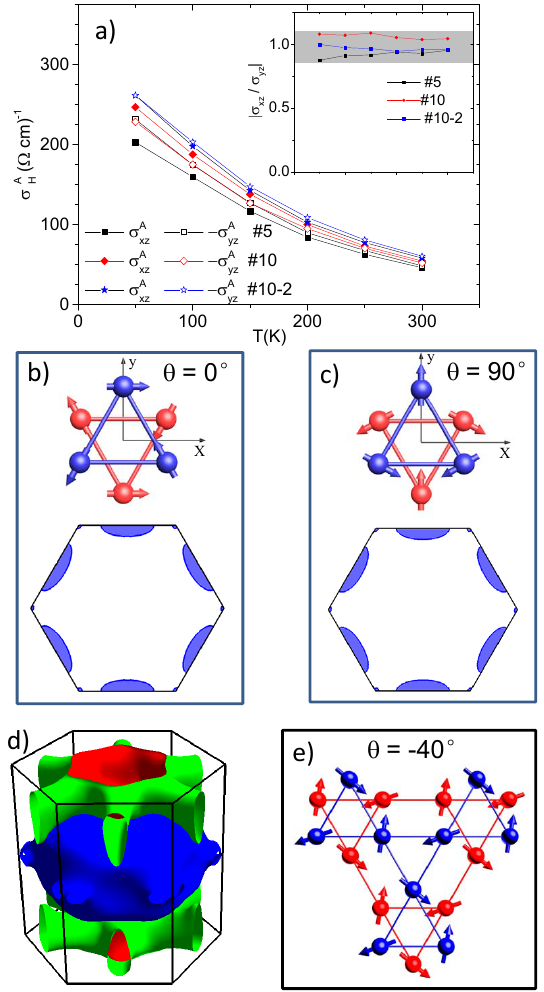
Figure 3: In-plane isotropy: a) Temperature-dependence of the anomalous Hall conductivity for two perpendicular orientations of the magnetic field in three dif- ferent samples. The inset shows the in-plane anisotropy found in these fixed-angle measurements and the experimental margin (in gray). b,c) Mn spins in two adjacent planes (in blue and red) together with the calculated Fermi surface for each spin configuration projected in the hexagonal ( k , k ,0 ) plane of the Brillouin zone. The x y Fermi surface does not visibly change with spin rotation. Note also the small circular Fermi surface at the vertices. d) The calculated Fermi surface of Mn Sn for θ = 0 in 3 three dimensions. Different colors show different Fermi surface sheets. e) Mn spins oriented along an arbitrary orientation in three adjacent six-spin David stars, each operating as a magnetic octupole [ 25 ]